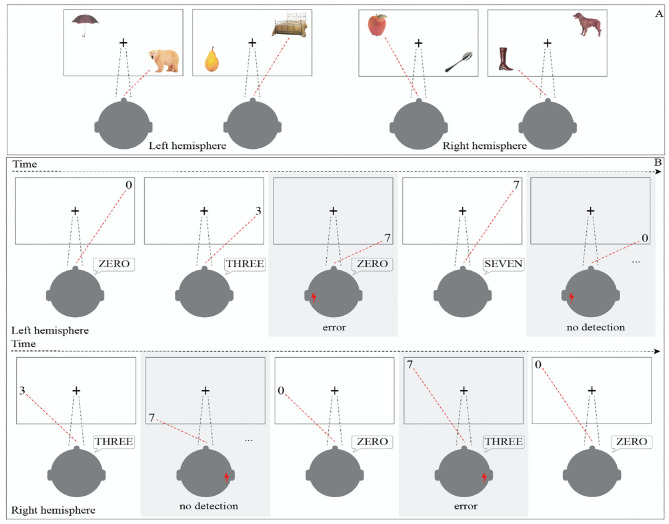
Intraoperative visual field tasks. (A) DPNT task: it consists in a modified version of the 4-screen naming task; two color items, selected out of Catricalà naming test items according to patient's performance, are placed diagonally (one in the quadrant planned to be tested and the other in the inferior contralateral side) on a 15” tablet screen. Patients during the test execution are invited to fix a red cross placed in the center of the screen, and to name both items. (B) iVT Intraoperative task: one number at a time was presented on a 15” screen and the patient was asked to name the number presented in the upper, lower, or middle (randomly) portion of the screen to allow the investigation of each quadrant of the peripheral visual field. In the upper and lower part of the figure the set up for the left or right hemisphere is, respectively, reported. The answer of the patient is reported in the bubble. The gray square and red lightning bolt represent the time at which the DES was applied over the investigated site.